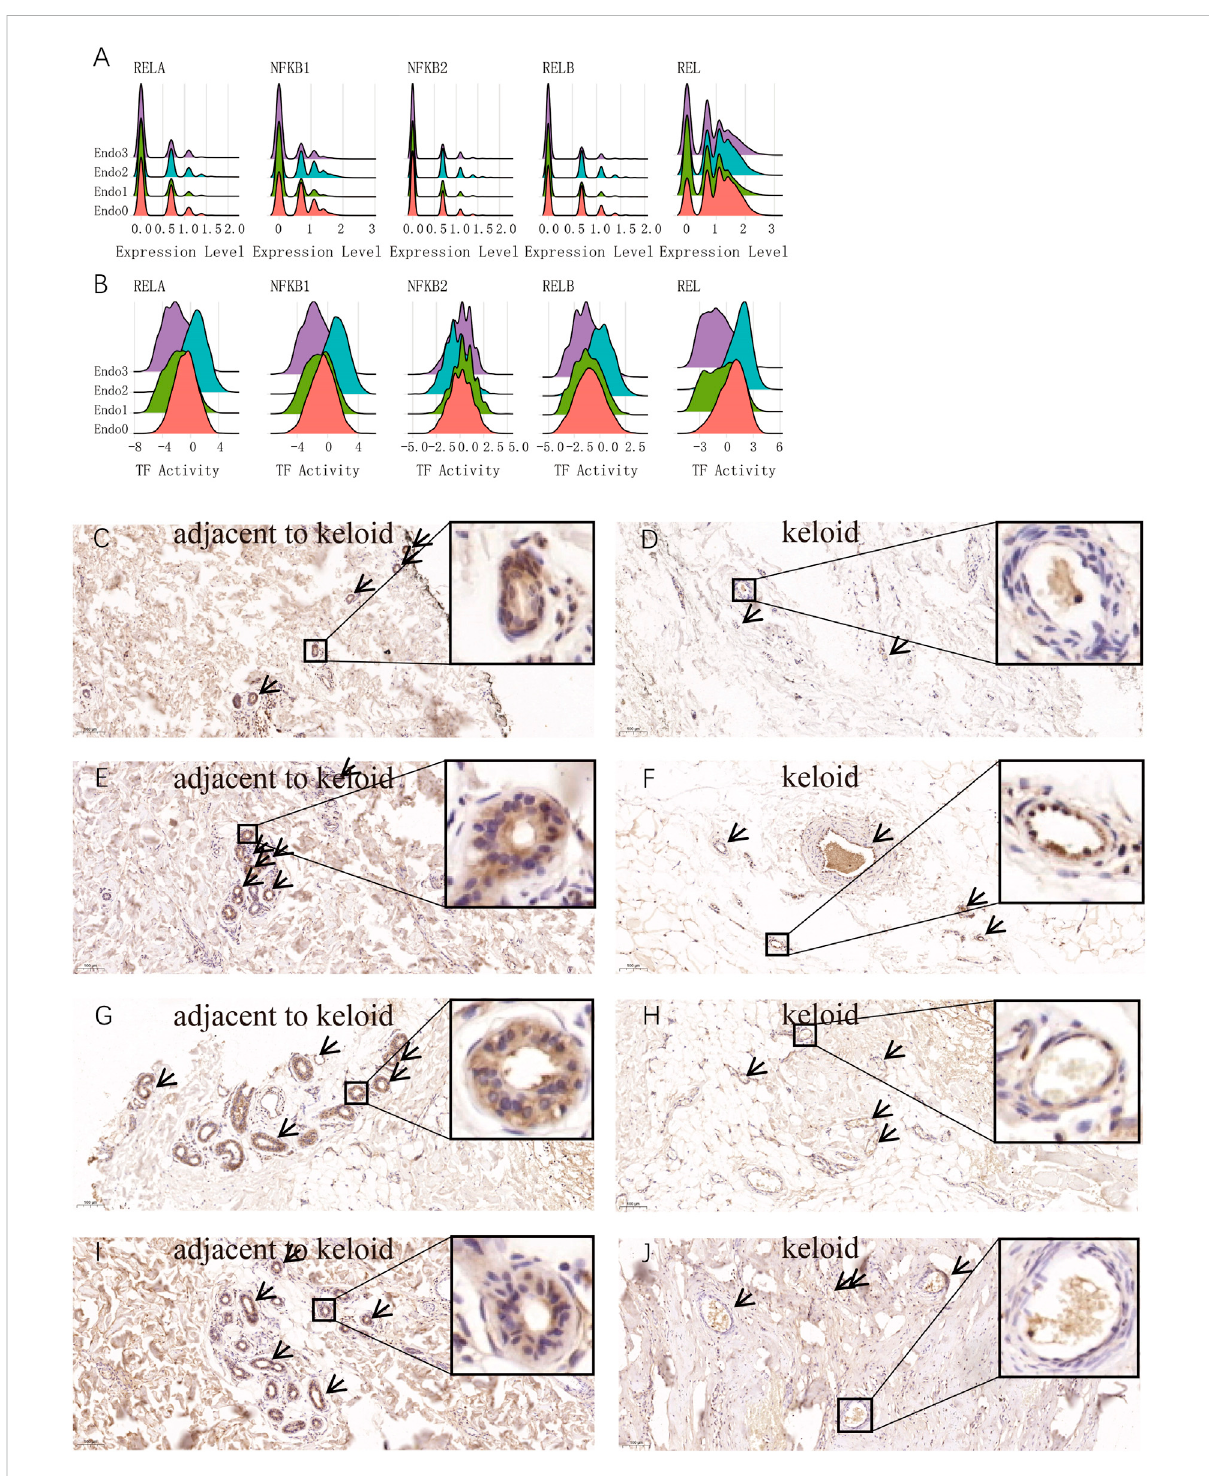
FIGURE 4 Activation of the NFKB signaling pathway is a major hallmark of activated endothelial cells Endo2. (A) Comparison of the distribution of gene expression of the main fi ve transcription factors of NFKB in four endothelial cell types. No signi fi cant differences in NFKB signaling pathway-related genes among the four endothelial cells. (B) Comparison of the distribution of the fi ve main transcription factor activities of NFKB in the four endothelial cells. The fi gure shows that RELA, NFKB1, RELB, and REL transcription factors are activated in Endo2, representing the activation of the classical NFKB signaling pathway in Endo2. (C – J) RELA immunohistochemical staining of keloid tissues and para-keloid tissues from four keloid patients. Figure C, E, G, I are normal skin tissues adjacent to the keloid; Figure D, F, H, J are lesions of the keloid. NFKB-activated Endo2 was clearly observed in the perivascular distribution and aggregation